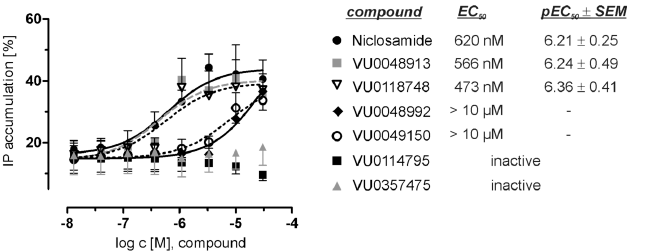
Fig 3. Y 4 R PAM activity of Niclosamide-like compounds. Potency of the Y 4 R PAMs was investigated with an inositol phosphate accumulation assay through potentiation of a PP EC 20 response. Data have been normalized to the maximum IP accumulation caused by the Y 4 R native ligand PP. Data represent the mean ± SEM of three independent experiments performed in